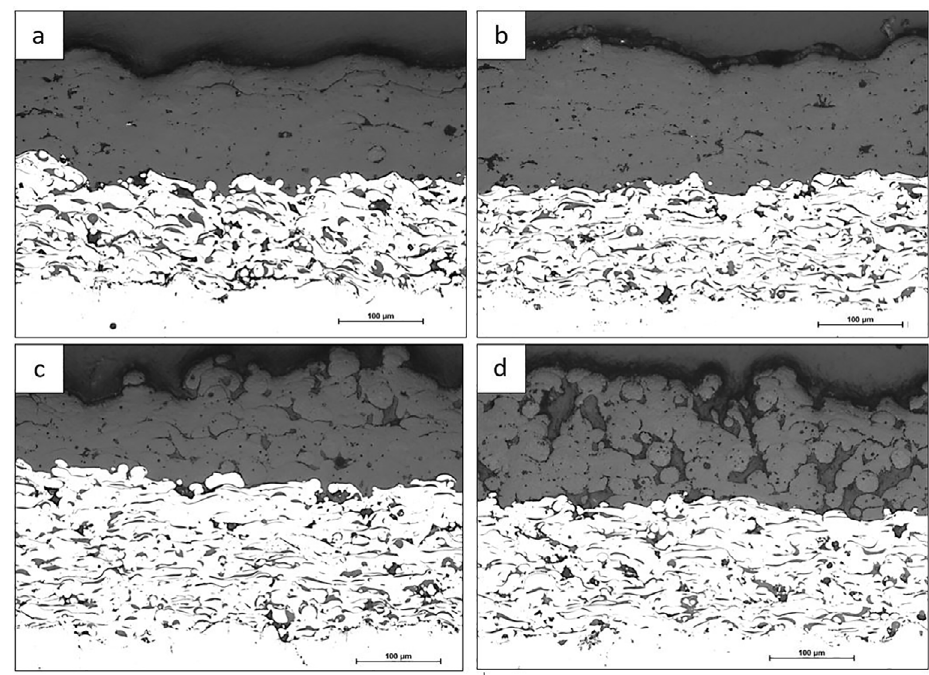
Figure 9. Aspect of the cross section of AT-13 coatings deposited with diverse oxygen: acetylene volumetric ratios and spraying distances. a) 1:2.5 - 110 mm, b) 1:2.5 - 140 mm, c) 1:1.7 - 110 mm, d) 1:1.7 - 140 mm